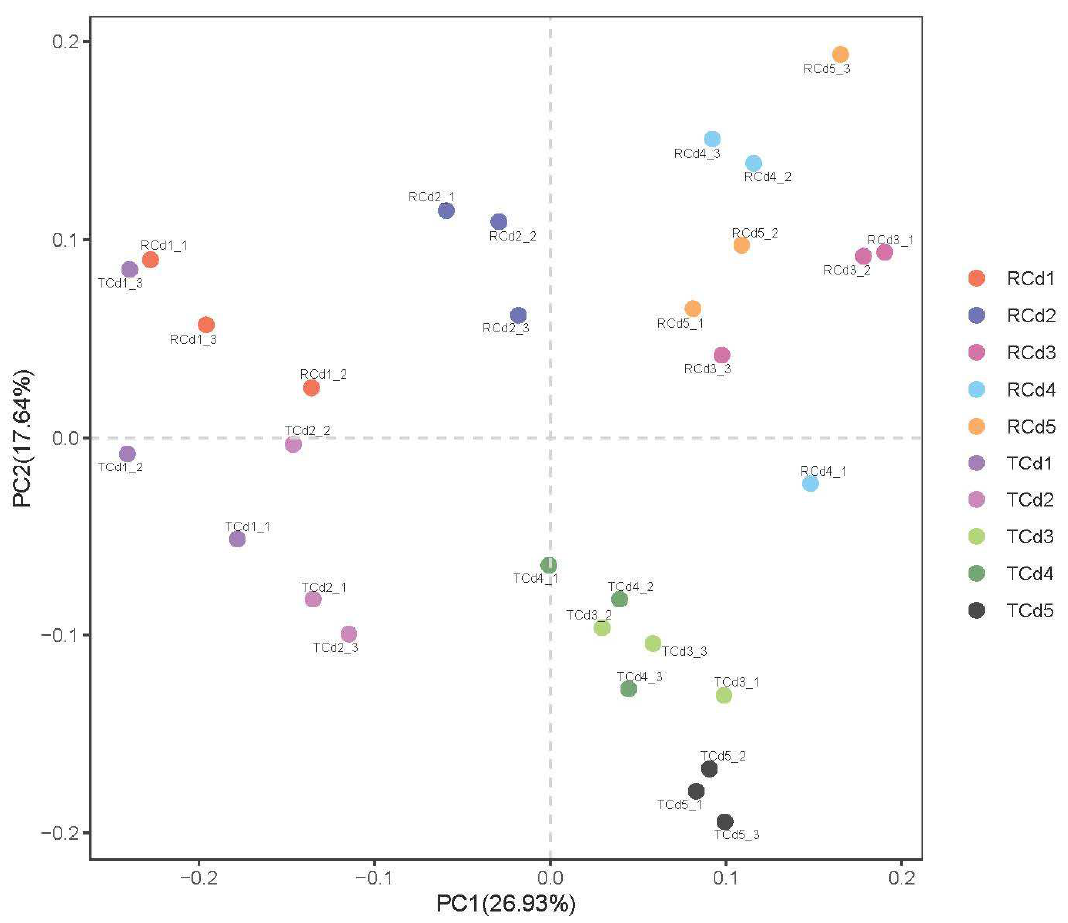
Figure 3. Principal component analysis (PCoA) of bacterial communities in the rhizosphere of different samples.